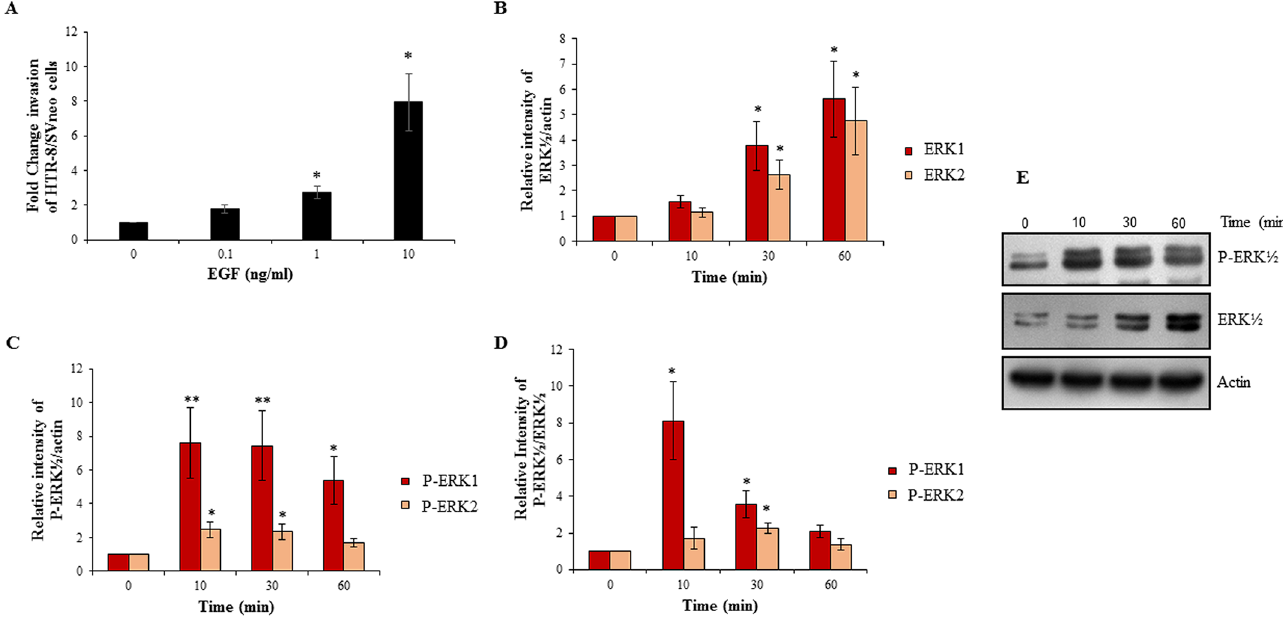
Fig 1. EGF treatment of HTR-8/SVneo cells increasesinvasion and activatesERK ½ signaling pathway. Cells were treated with varying concentrations of EGF (0.1, 1, 10 ng/ml). Panel A shows fold changein invasionof EGF-treated cells with respect to untreated naive control cells. Values are expressedas mean ± SEM of three independentexperiments performed in duplicates. Further experiments were performed by treating cells with optimizedEGF concentration (10 ng/ml) for varyingtime periods(10, 30 and 60 min) followedby Western blot analysisto determine activationof ERK ½ as describedin Materialsand Methods . Panel B represents the densitometric plot of relativeincrease in total ERK 1 and 2 in EGF treated cells with respect to untreatedcontrol as comparedwith actin. PanelsC and D represent the densitometric plots showingthe relative increase in phosphorylated ERK 1 and 2 in EGF treated cells with respect to untreatedcontrol as compared to actin and total ERK 1 and 2 respectively.Panel E shows representative blots from one of the three independent experiments. The data in Panels B, C and D is representedas mean ± SEM of three independentexperiments and band intensitiesof phosphorylated and total ERK ½ were normalizedwith respect to loadingcontrol duringdensitometric analysis. * p < 0.05 and ** p < 0.01 with respect to untreated control cells.